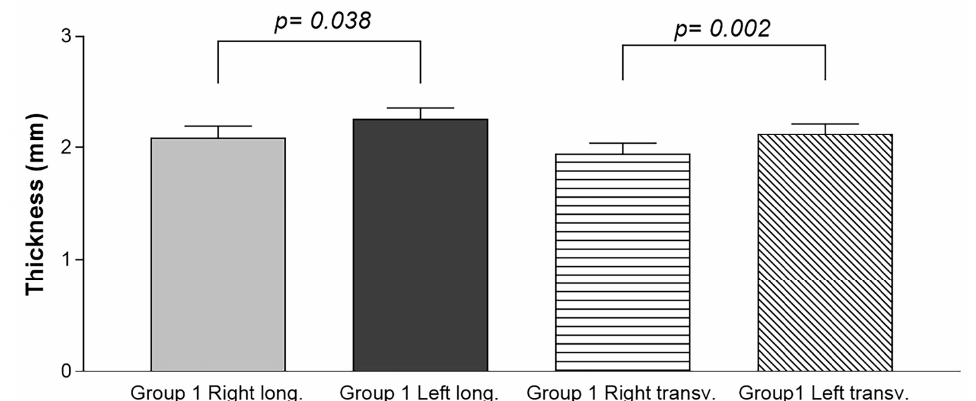
Figure 2. Ultrasound thickness measurements of the TLF in the chronic non-specific LBP patients (Group 1). Long.: longitudinal axis; transv.: transverse axis.